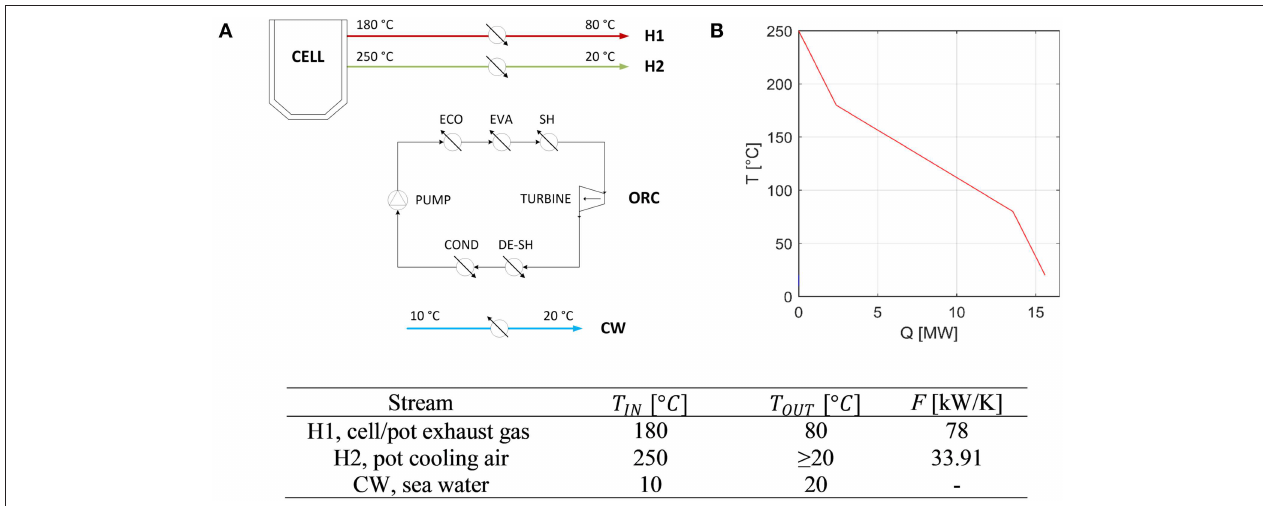
FIGURE 1 | General scheme of the case study (A) and composite curve of the available hot process streams (B) , and data for the aluminum manufacturing plant case